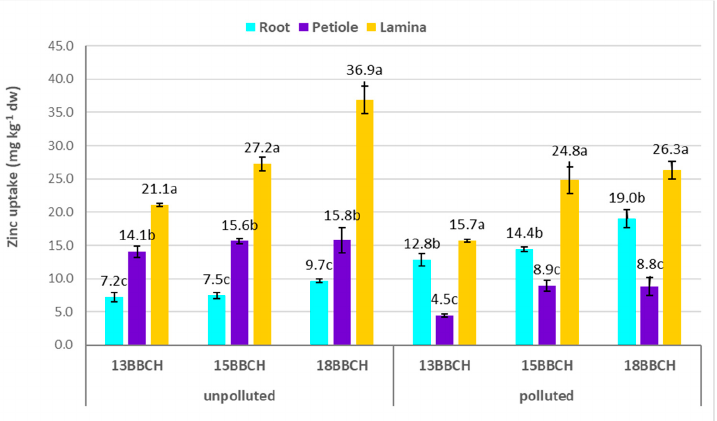
Figure 5. Zn uptake in S. perfoliatum organs for different development stages when grown in Us. Error bars represent SE. Different letters (a, b, c) indicate significant differences ( p < 0.05) between plant organs .